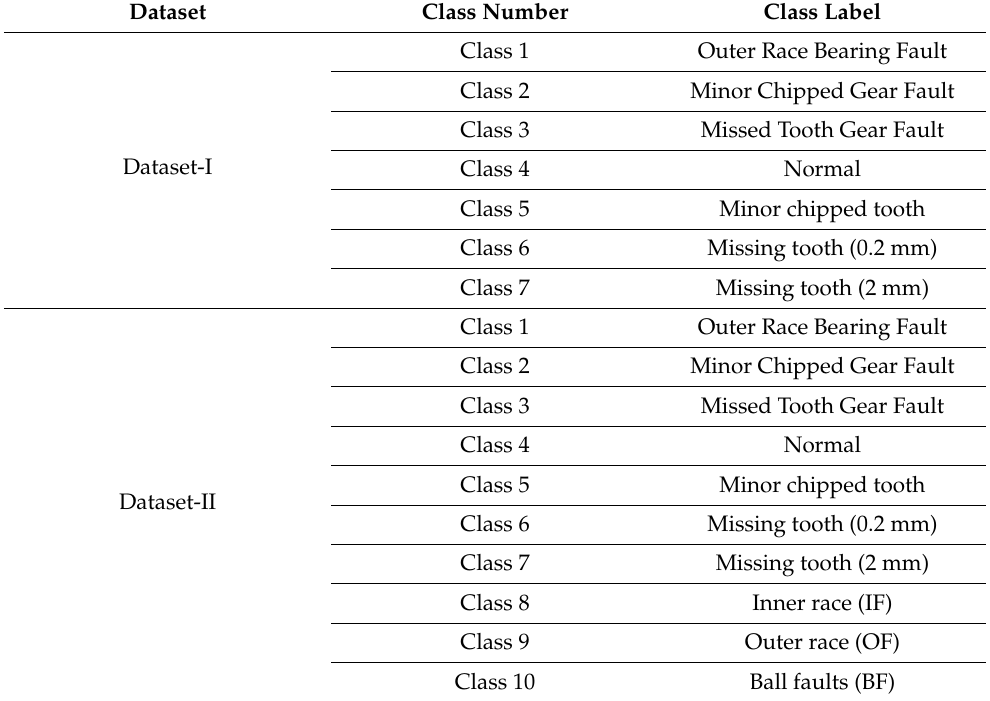
Table 1. Dataset details.